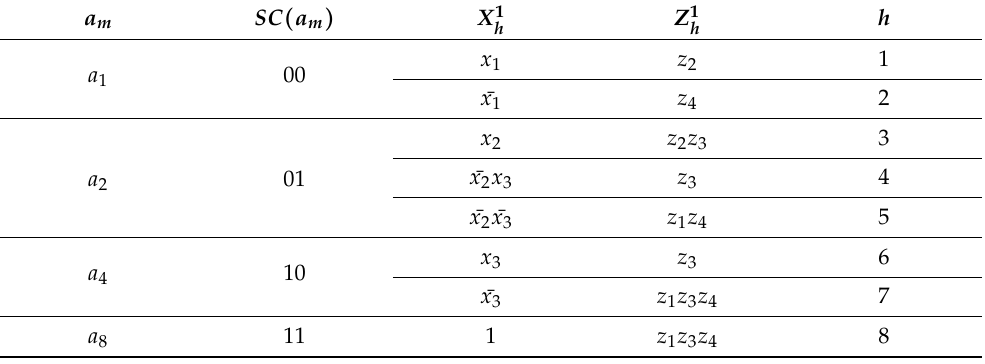
Table 4. Table of LUTerZ 1.